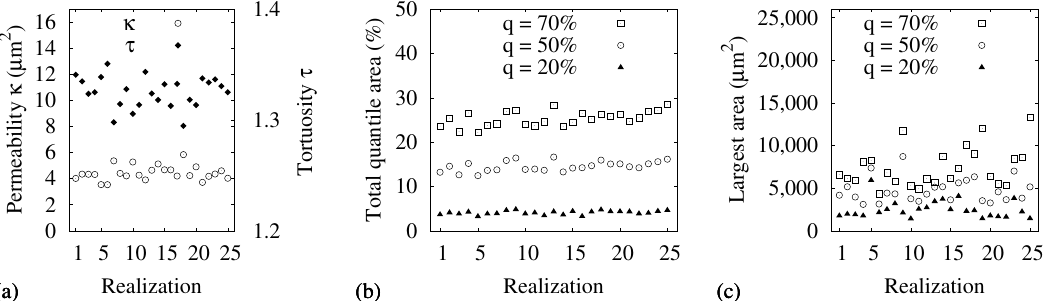
Figure 6. Impact of compression, 30% compressed, slip condition at walls: ( a ) permeability and tortuosity; ( b ) relative total quantile areas of the gas flow; total area where u q ( z ) > 0. ( c ) The largest area from ( b